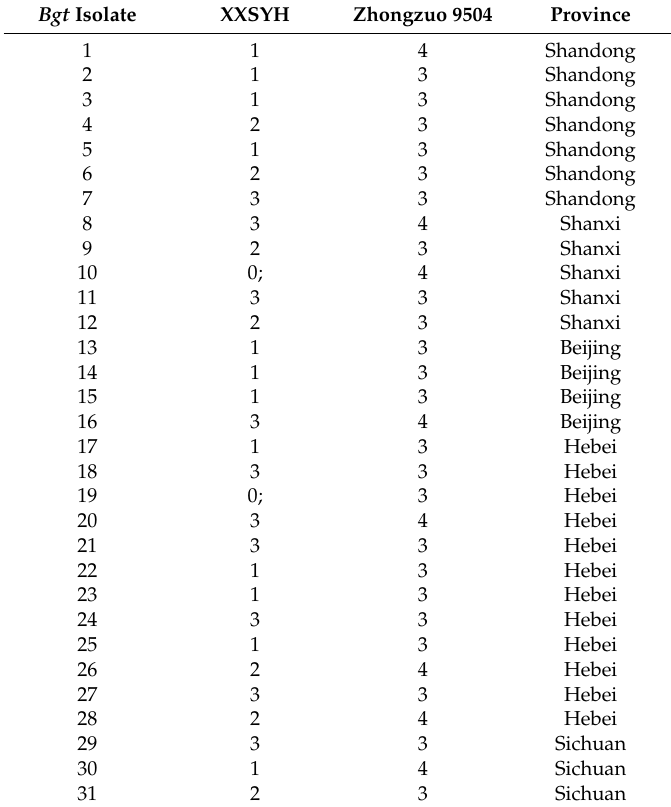
Table 1. Infection types of Xuxusanyuehuang (XXSYH) and Zhongzuo 9504 to 30 Blumeria graminis f. sp. tritici ( Bgt ) isolates from different provinces of